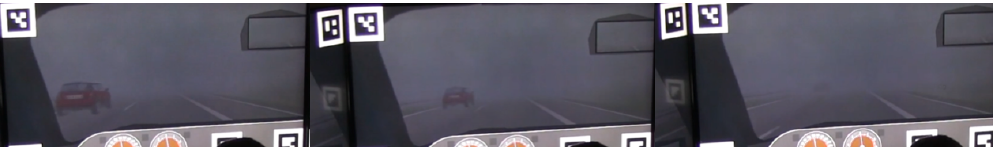
Figure 5. Visibility in the foggy scenarios. Vehicles disappear at a distance of approximately 33